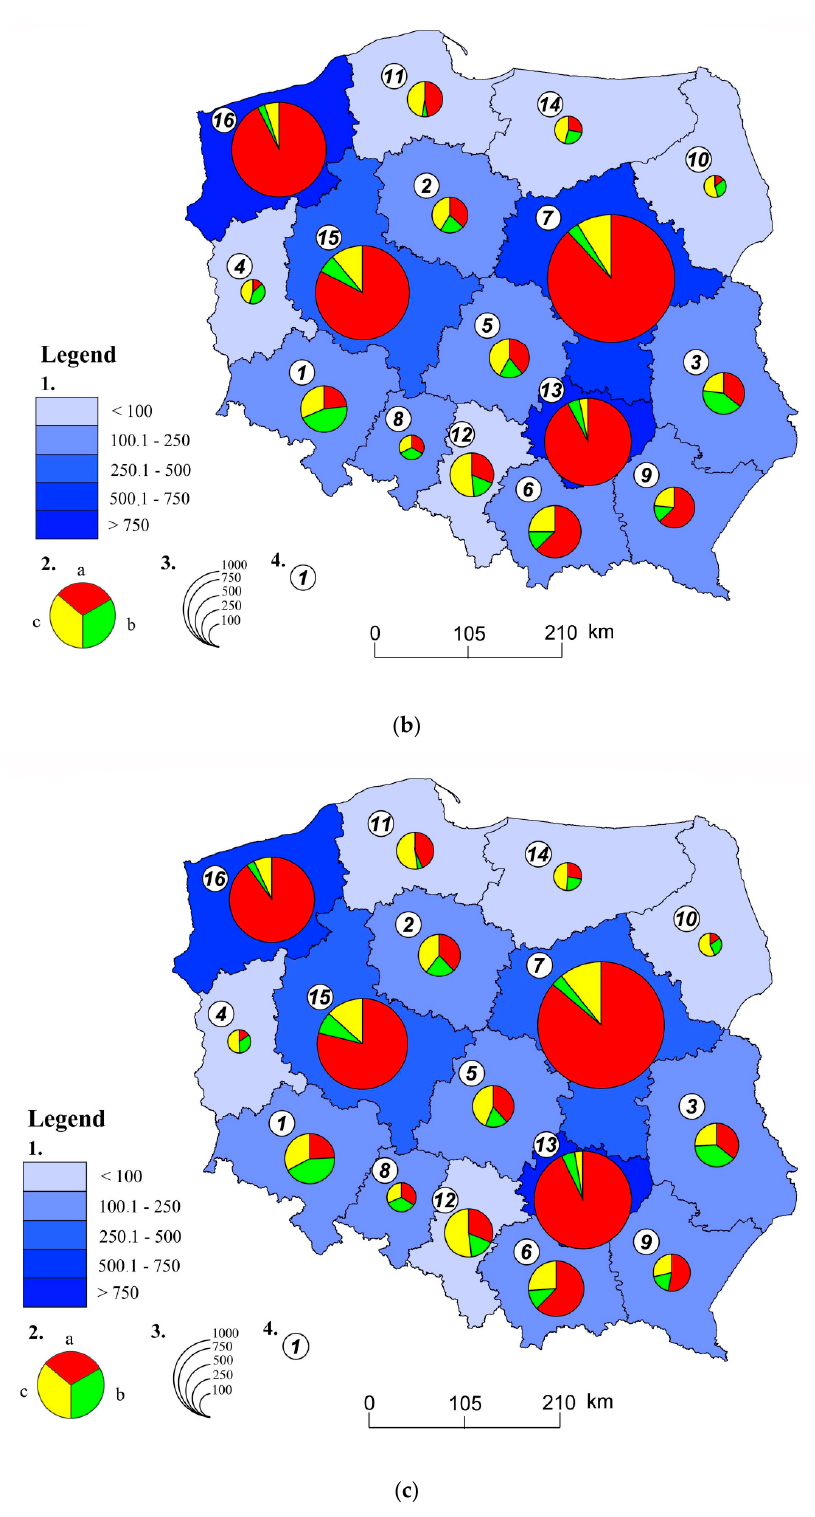
Figure 11. Structure of water consumption in Poland (by voivodeship) in 2010 ( a ), 2015 ( b ) and 2018 ( c ) (based on [26]). Explanations: 1—water consumption in m 3 / capita; 2—share of % of water